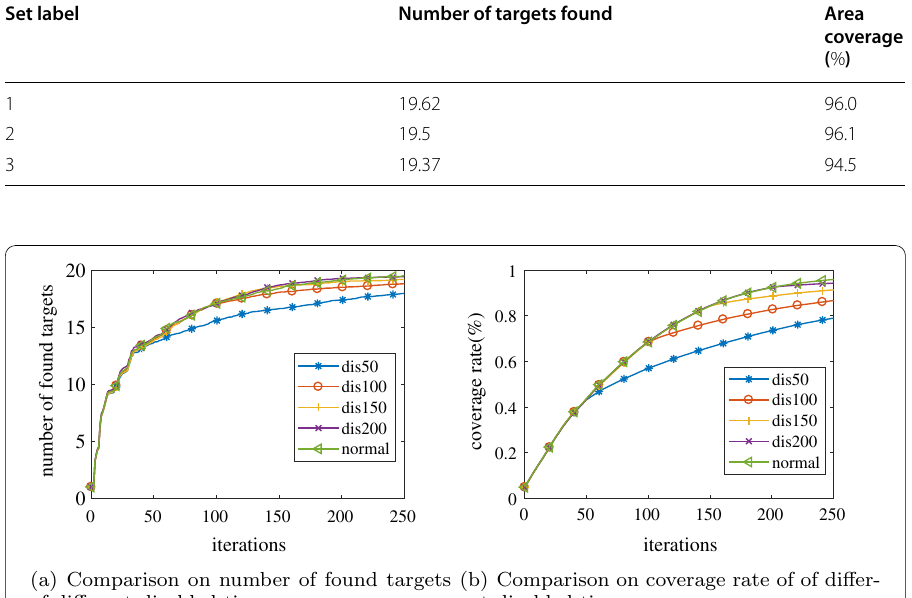
(b) Comparison on coverage rate of of differ- ent disabled time.